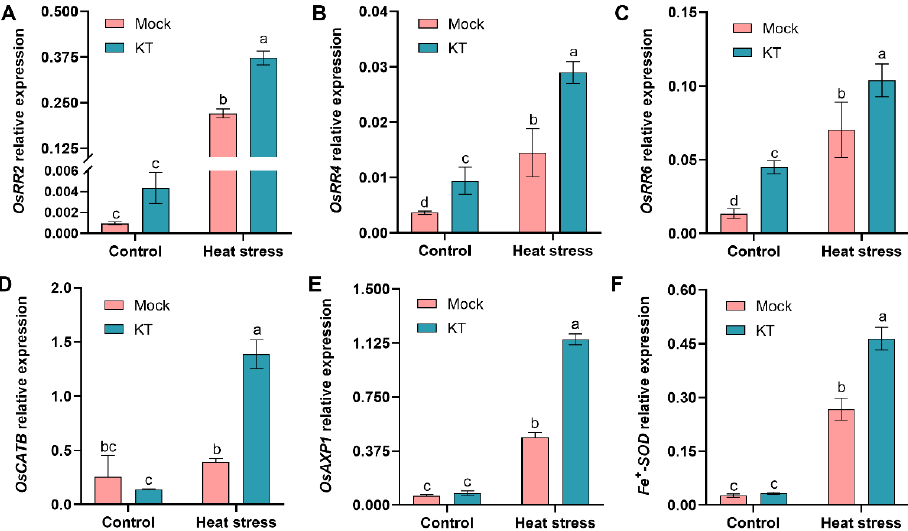
Figure 4. Relative expression of CK response and antioxidant-related genes in 10 −9 M KT under heat stress. For qRT-PCR, OsActin1 was used as internal reference to analyze the relative expression of CK response genes, OsRR2 ( A ), OsRR4 ( B ), and OsRR6 ( C ), and antioxidant-related genes, OsCATB ( D ), OsAXP1 ( E ), and Fe + -SOD ( F ). Data are means ± SD. Different lowercase letters show significant differences among treatments analyzed by one-way ANOVA comparison test (n = 3, p < 0.05).